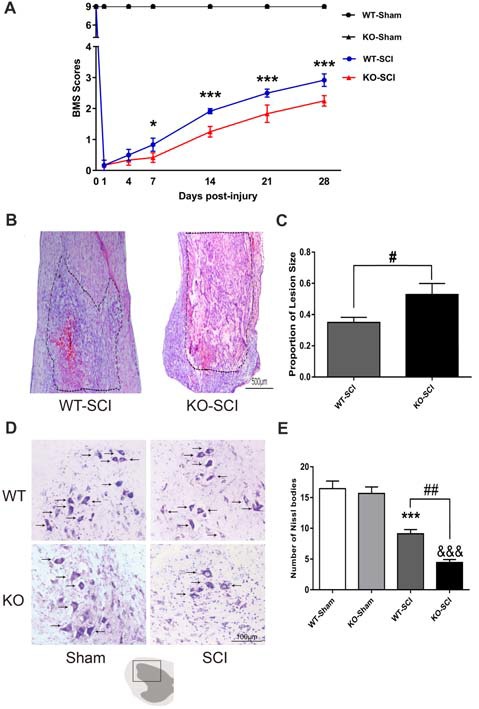
Apoe deficiency retards motor functional recovery and increases lesion area following SCI. (A) Statistical analysis of motor functional recovery of WT and Apoe KO mice before and after SCI using Basso Mouse Scale (BMS) scores. Data are expressed as mean ± SEM of seven independent experiments (n = 6 per group). *p < 0.05, ***p < 0.001, WT-SCI vs. KO-SCI, 7 days, p = 0.0493; 14 days, p = 0.0004; 21 days, p = 0.0004; 28 days, p = 0.0004, two-way ANOVA followed by Tukey’s post hoc test. (B) Representative micrograph of longitudinal spinal cord sections stained with H & E in both Apoe KO and WT mice at 7 days post-injury. The boundary of the lesion is outlined with a dotted line. (C) Quantitative analysis of the lesion area that determined from the length from injury site rostral and caudal 0.5 cm and expressed as percentage of lesion area per spinal cord analyzed. Four representative sections per animal (one of every ten serial sections) were stained. Data are expressed as mean ± SEM of three independent experiments (n = 6 per group). #p < 0.05, WT-SCI vs. KO-SCI, p = 0.0392, Student’s t-test, Scale Bars = 500 μm. (D) Representative sections showing normal neurons that contained prominent nucleoli, loose chromatin, and Nissl body (arrow). (E) Quantitative analysis of motor neurons in the ventral horn at 7 days post-injury. Four transverse sections were chosen at ±300 μm, ±600 μm from rostral to caudal around the epicenter were obtained from each animal. Data are expressed as mean ± SEM of three independent experiments (n = 6 per group). ***p < 0.001, WT-Sham vs. WT-SCI, p < 0.001; &&&p < 0.001, KO-Sham vs. KO-SCI, p < 0.001; ##p < 0.01, WT-SCI vs. KO-SCI, p = 0.0055, one-way ANOVA followed by Tukey’s post hoc test, Scale Bars = 100 μm.